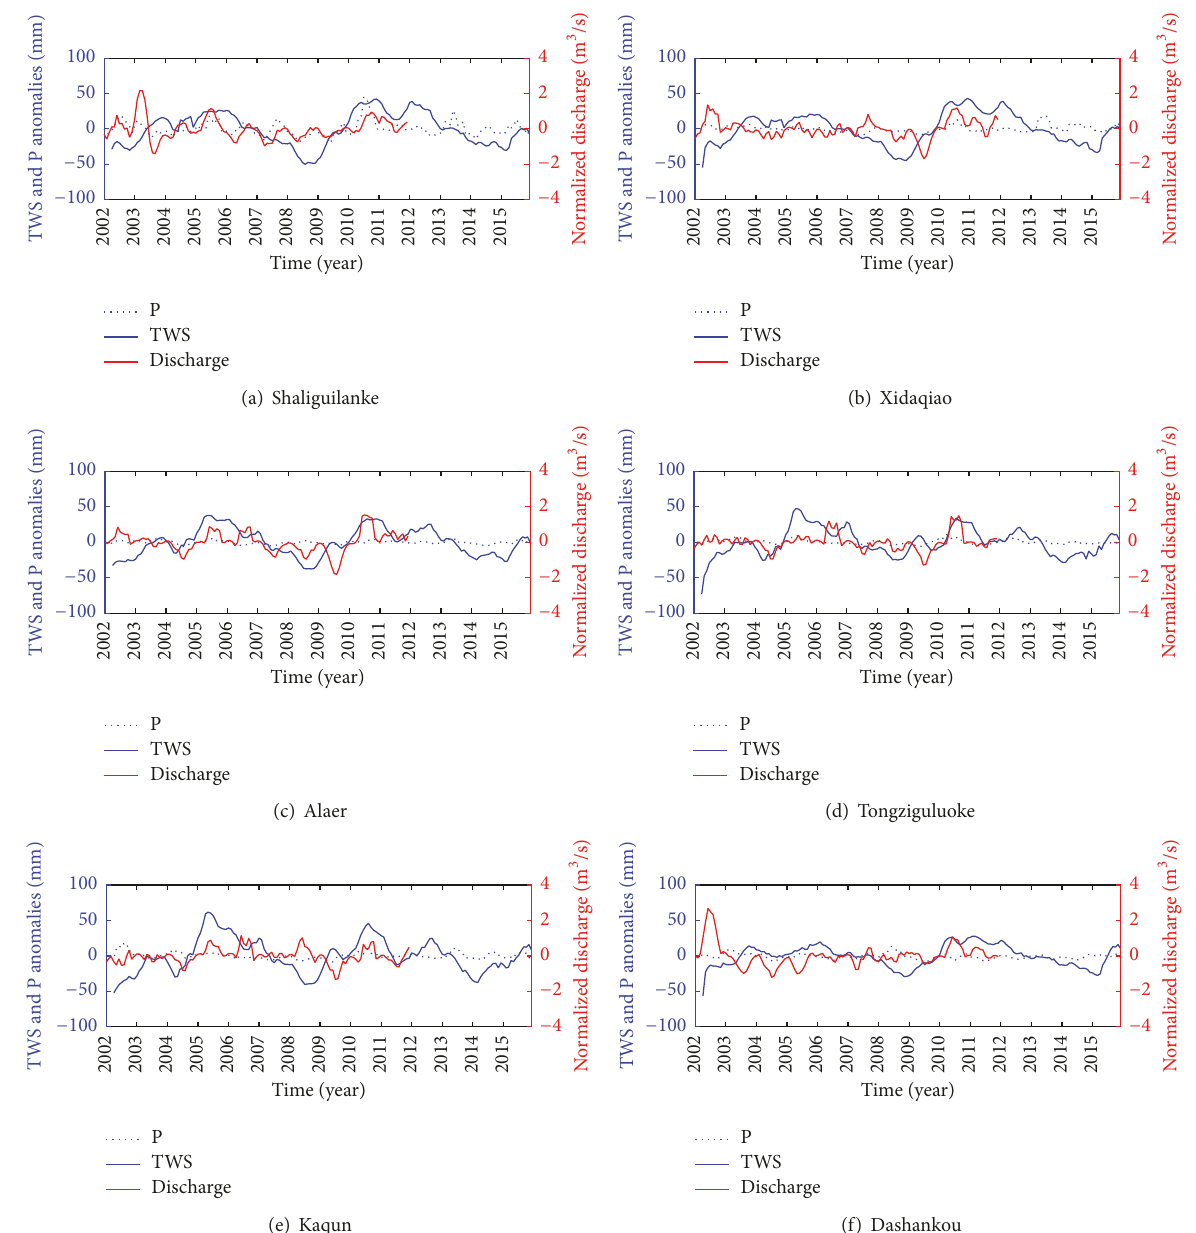
Figure 5: Time series of nonseasonal TWS anomalies, precipitation anomalies, and discharge anomalies in the six hydrological stations of TRB. (a) Shaliguilanke; (b) Xidaqiao; (c) Alaer; (d) Tongziguluoke; (e) Kaqun; (f) Dashankou.